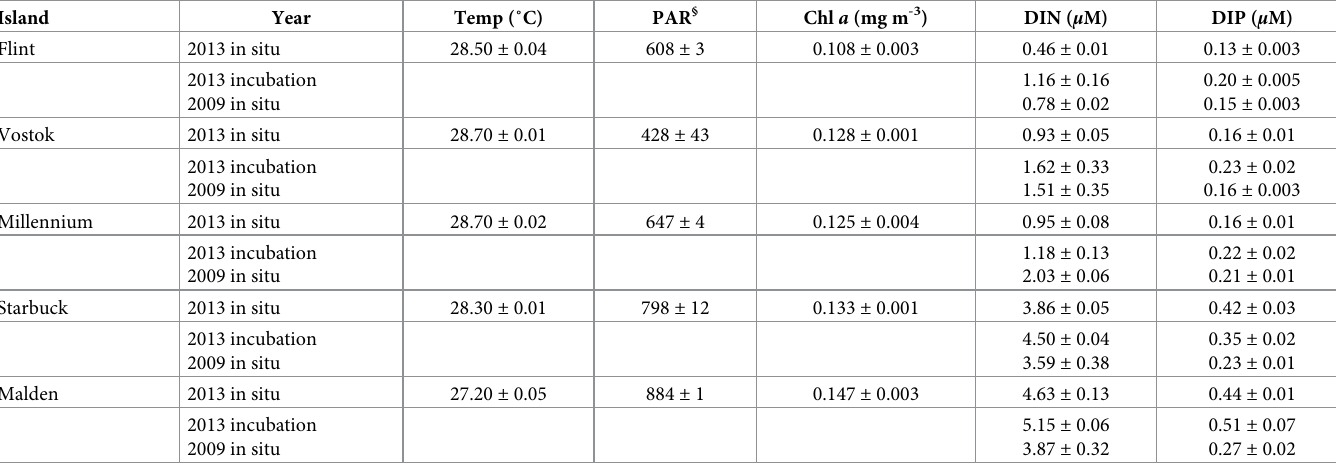
Table 1. Environmental parameters across the Southern Line Islands, with islands listed from south to